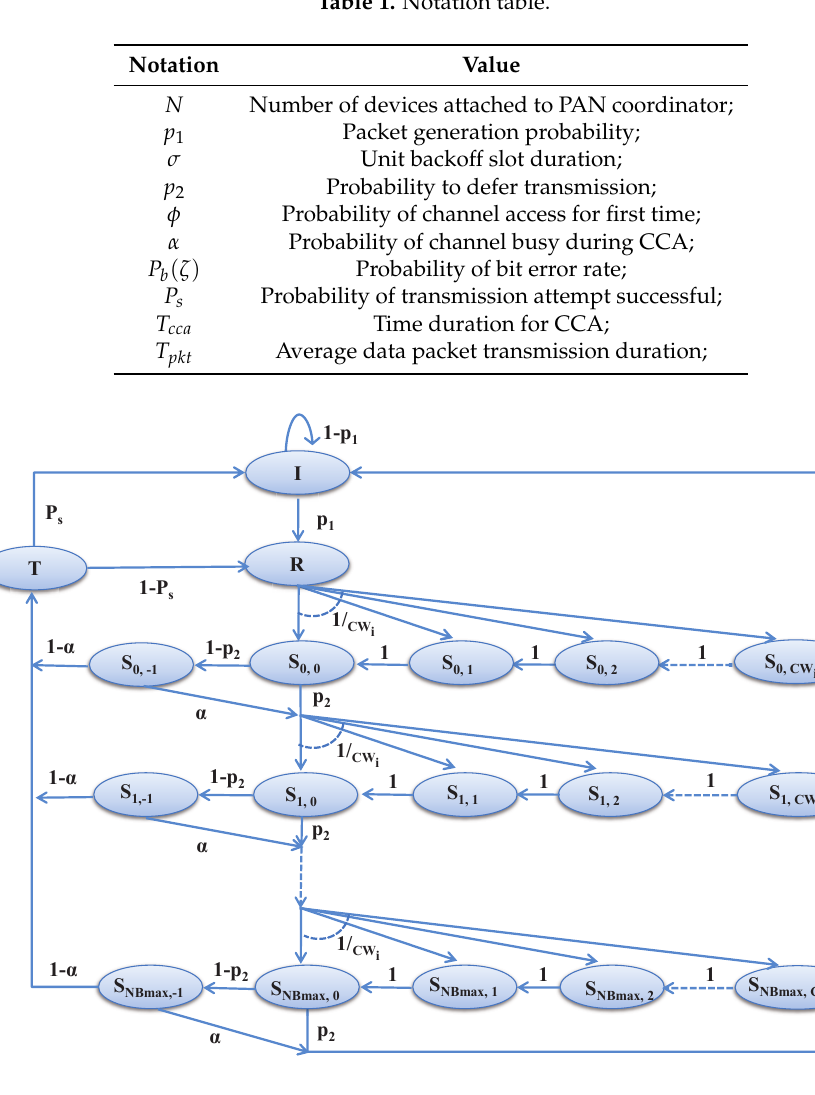
Figure 8. Markov chain model for the proposed channel access